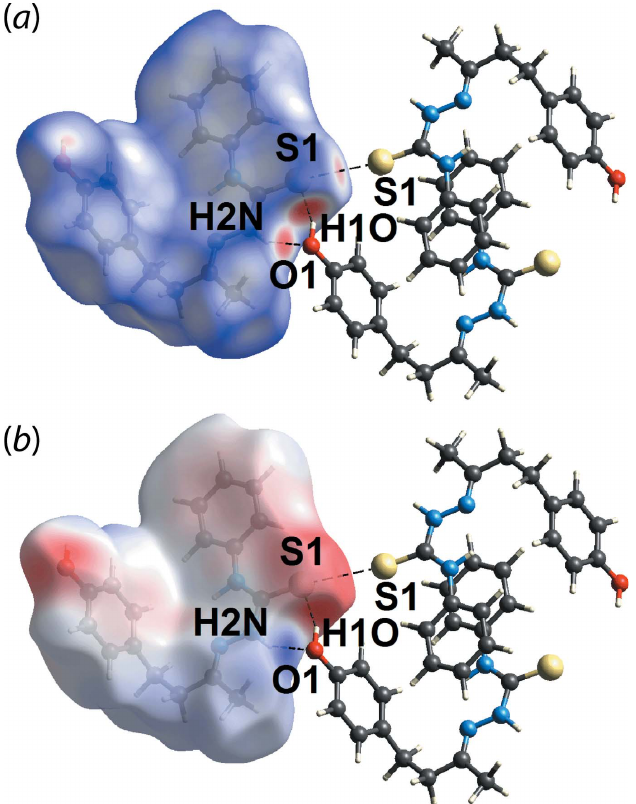
Figure 3 Views of the Hirshfeld surface for (I) mapped over ( a ) d norm in the range (cid:3) 0.490 to +1.188 arbitrary units and ( b ) the calculated electrostatic potential in the range of (cid:3) 0.072 to +0.133 atomic